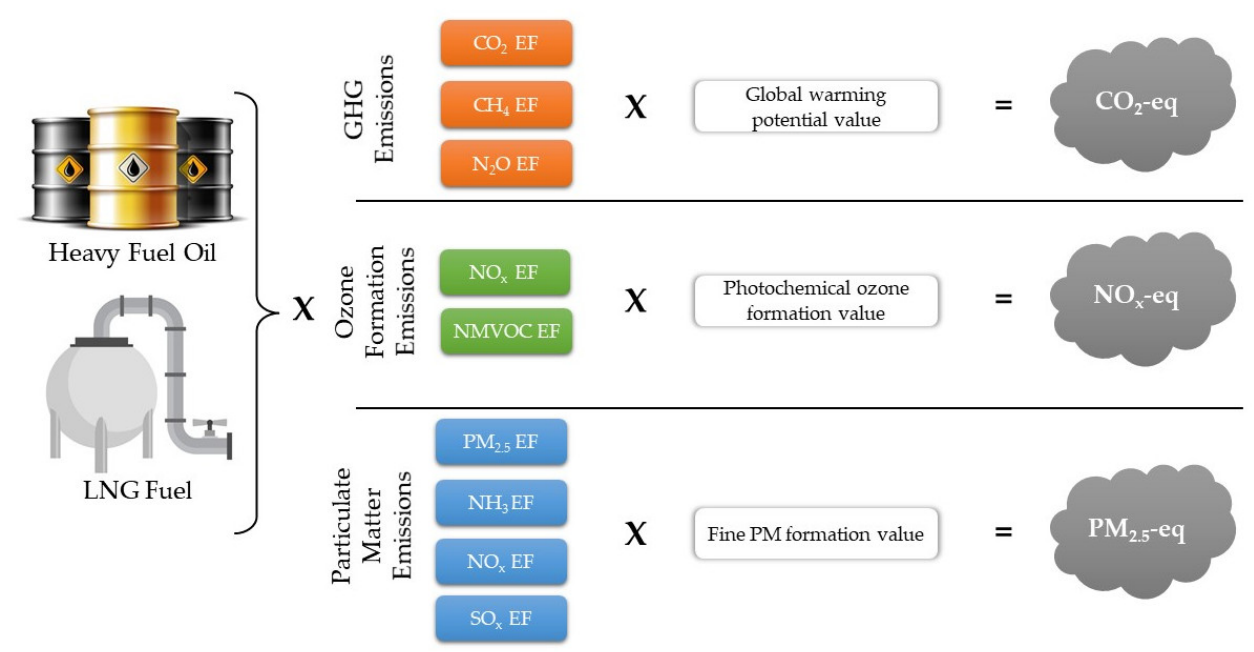
Figure 3. The calculation methodology for CO 2 -eq, NO x -eq, and PM 2.5